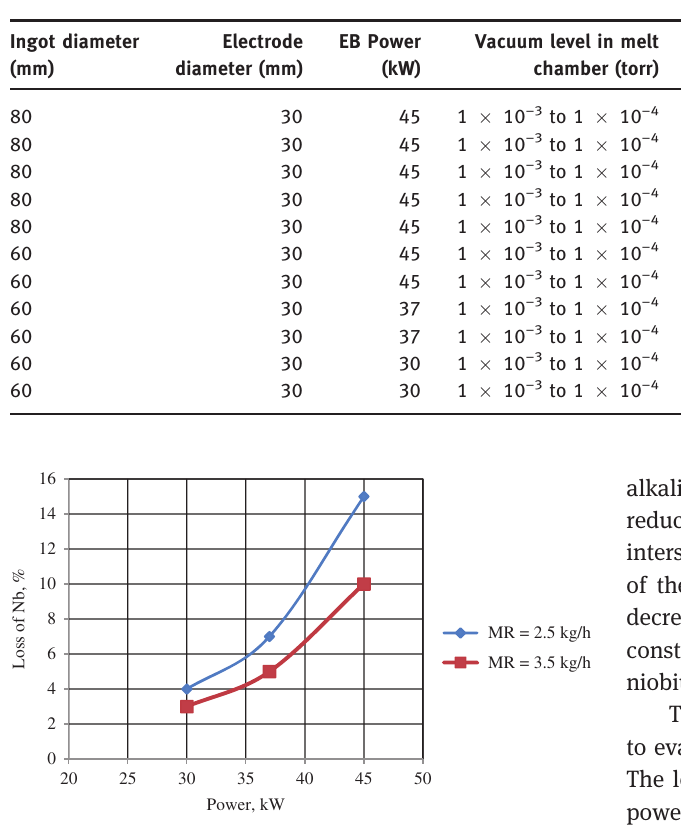
Figure 5: Effect of input power and melt rate on the loss of Nb during EB melting in 60 mm diameter